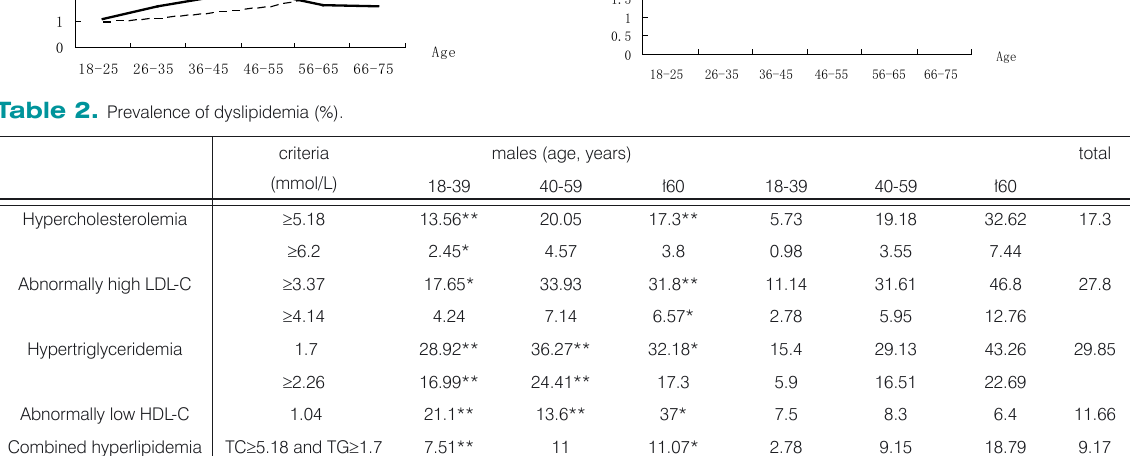
Table 2. Prevalence of dyslipidemia Figure 1.Age trends for mean TC and TG in females (dashed lines)and males(solid lines).